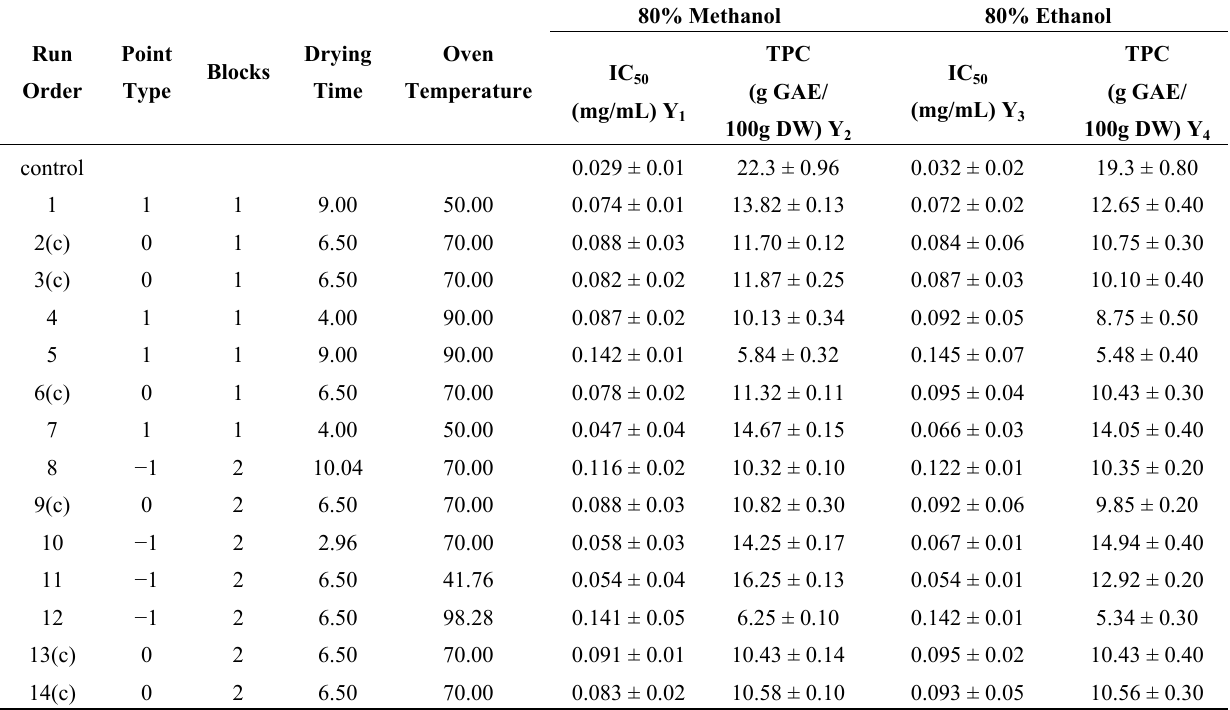
Table 1. RSM CCD cubic design and response variables (IC and 80%